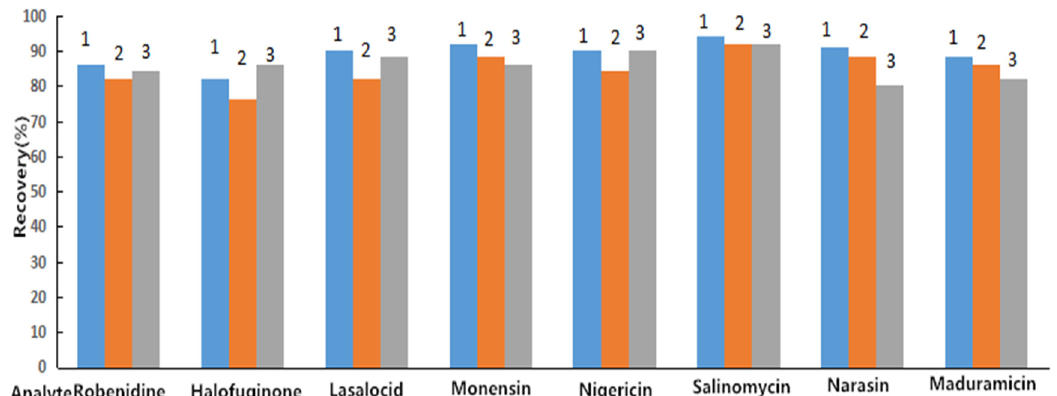
Figure 1. Comparison of the recovery of eight coccidiostats in eggs via different solid-phase extraction cartridges. Note: 1. CNW C 18 cartridge; 2. SIMON C 18 cartridge; 3. BOSHI C 18 cartridge.